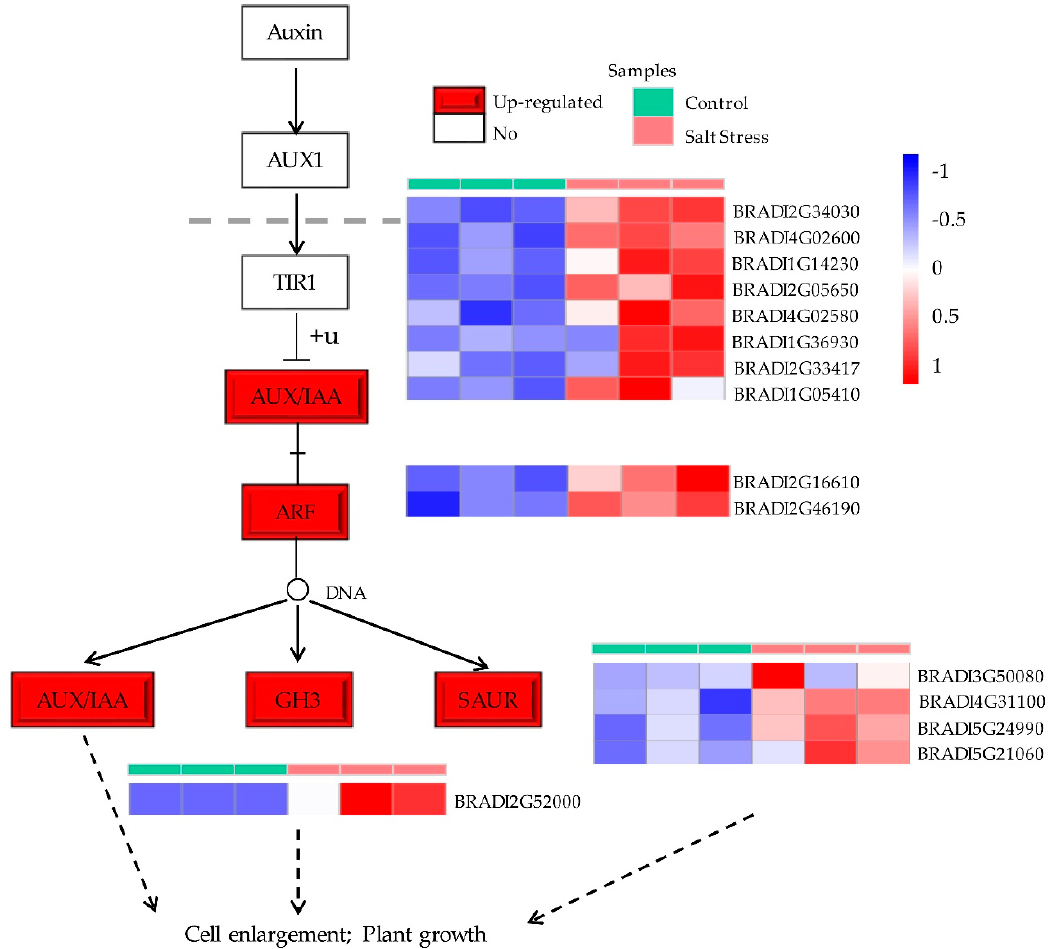
Figure 6. The auxin signal transduction pathway obtained by Kyoto Encyclopedia of Genes and Genomes (KEGG) enrichment analysis. There were 17 DEGs mapped to this pathway. The red boxes indicate that the upregulated genes were enriched in this node. The blank boxes represent nodes with no DEG enrichment.